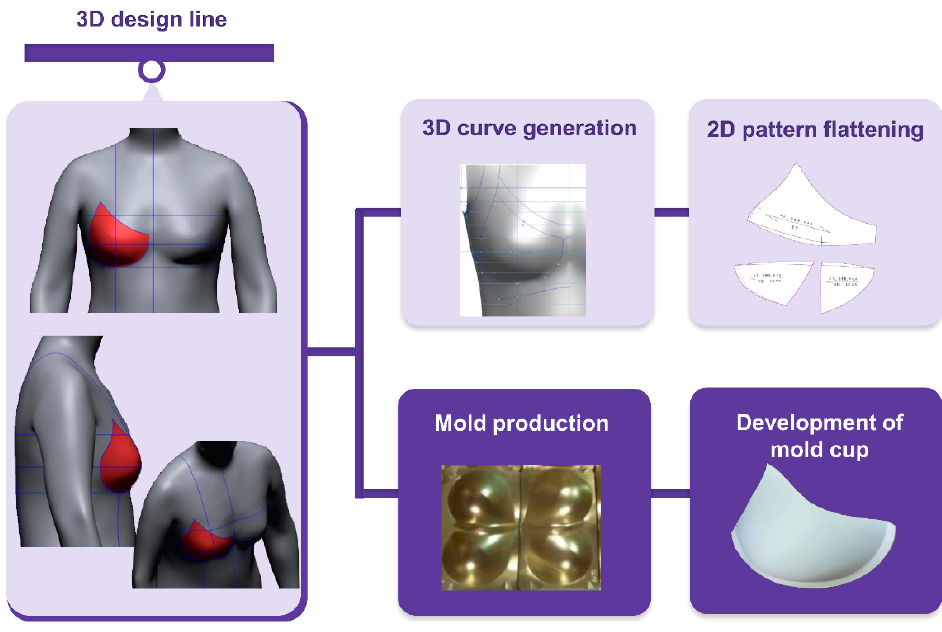
Figure 2. 3D molded bra cup development